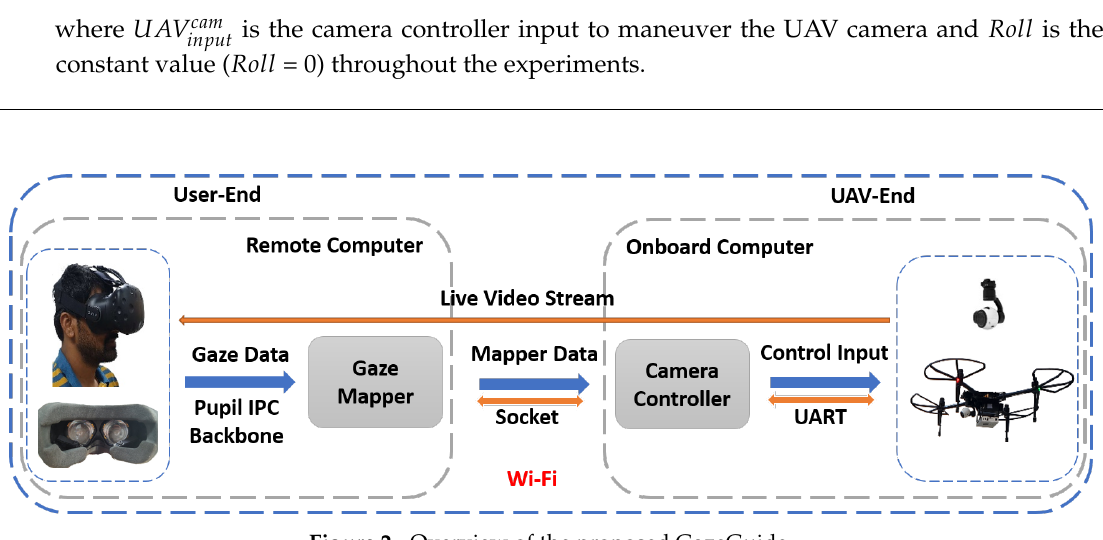
Figure 2. Overview of the proposed GazeGuide.